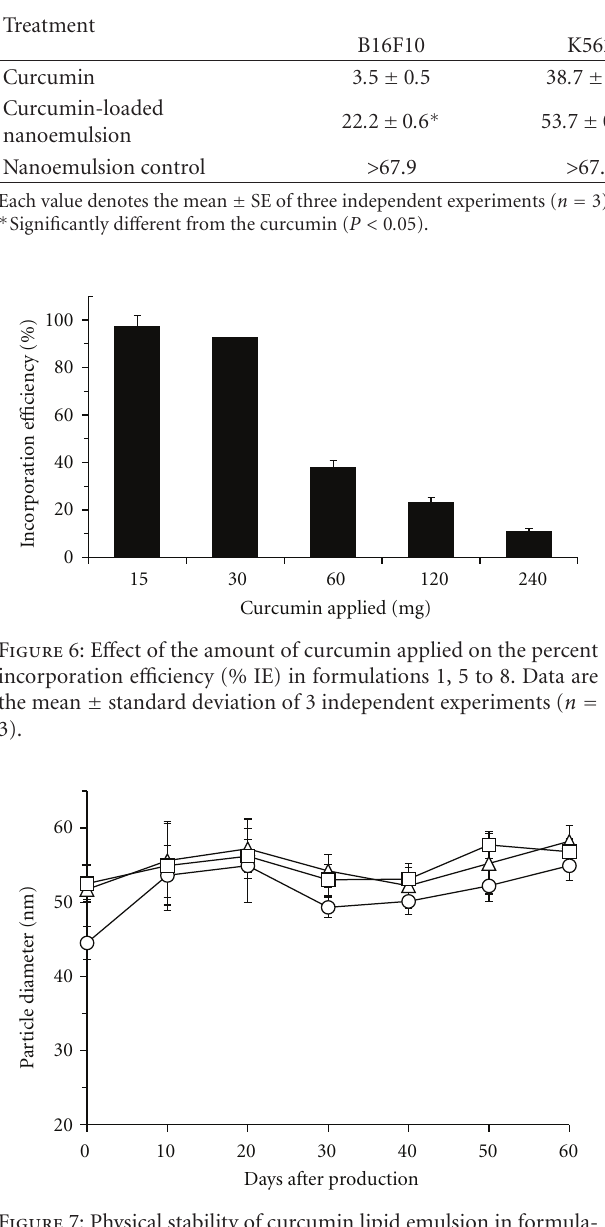
Figure 7: Physical stability of curcumin lipid emulsion in formula- tions 1, 5, and 6 during storage at 4 ◦ C for 60 days. Curcumin applied (mg): circle, 15; triangle, 30; square, 60. Data are represented as the mean ± standard deviation of 3 independent experiments ( n =